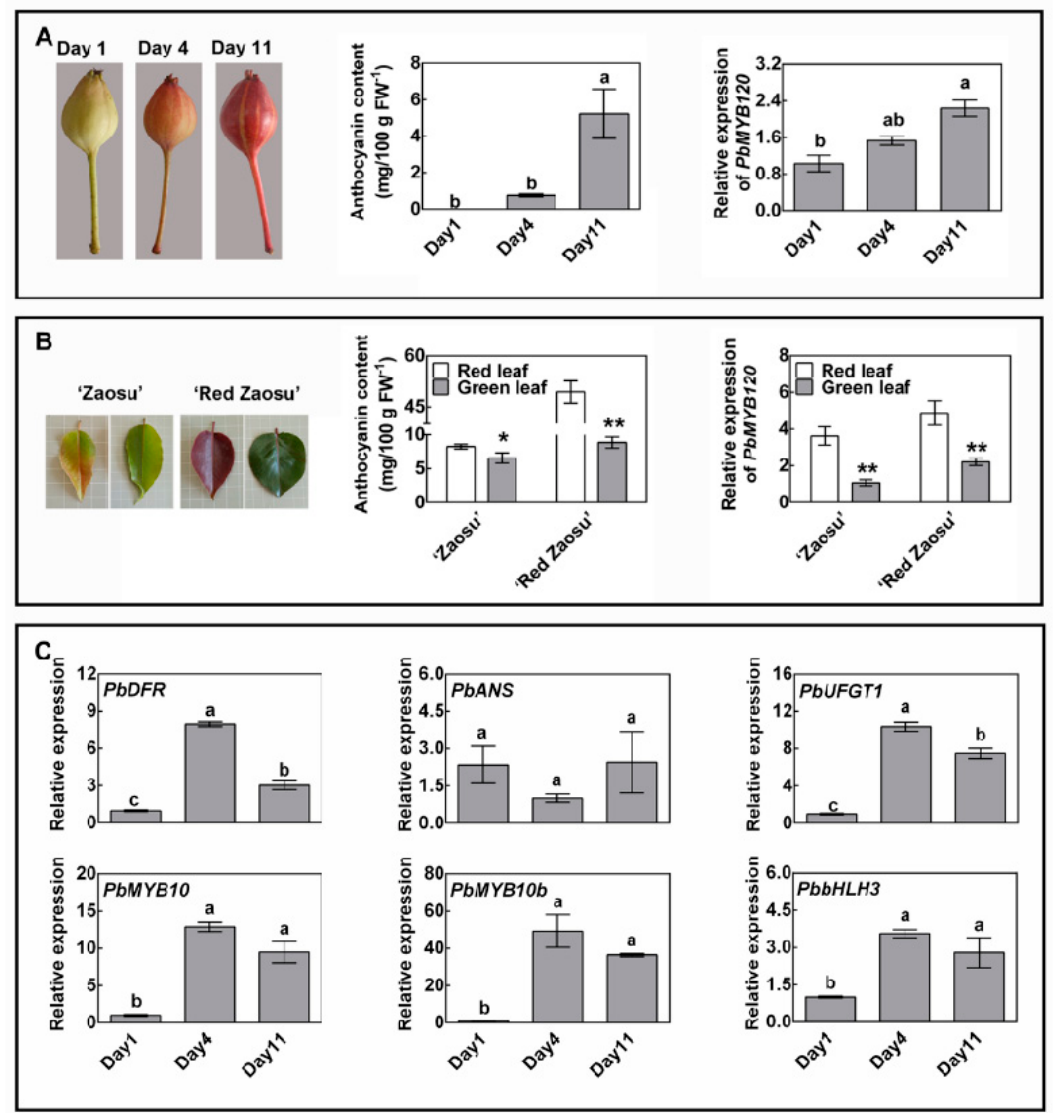
Figure 4. Role of PbMYB120 in increase and decrease of anthocyanin accumulation. ( A ) Analysis of anthocyanin accumulation and PbMYB120 expression during light-induced fruit coloration of ‘Red Zaosu’. Young fruit of ‘Red Zaosu’ were bagged and faded completely after 30 days of shading. Days 1, 4, and 11 represent 1, 4, and 11 days after removing the fruit bags, respectively. ( B ) Analyses of anthocyanin accumulation and PbMYB120 expression during the natural fading of leaf coloration of ‘Zaosu’ and ‘Red Zaosu’. Young leaves with red coloration and mature leaves with green coloration were analyzed. Leaves were light- or deep-red colored at the young stages. The red coloration decreased during the leaf developmental process and disappeared eventually. Leaves were green colored at the mature stages. ( C ) Expression analysis of genes involved in anthocyanin pathway in light-induced fruit coloration of ‘Red Zaosu’. Data are the means ± SEs of three biological replicates. Di ff erences between two samples were assessed using Student’s t test at a 95% confidence level and are indicated by asterisks (* p < 0.05, ** p < 0.01). Di ff erences among the three samples were assessed using one-way ANOVA with Tukey’s honestly significant di ff erence test at a 95% confidence level and are indicated by lowercase letters above the error